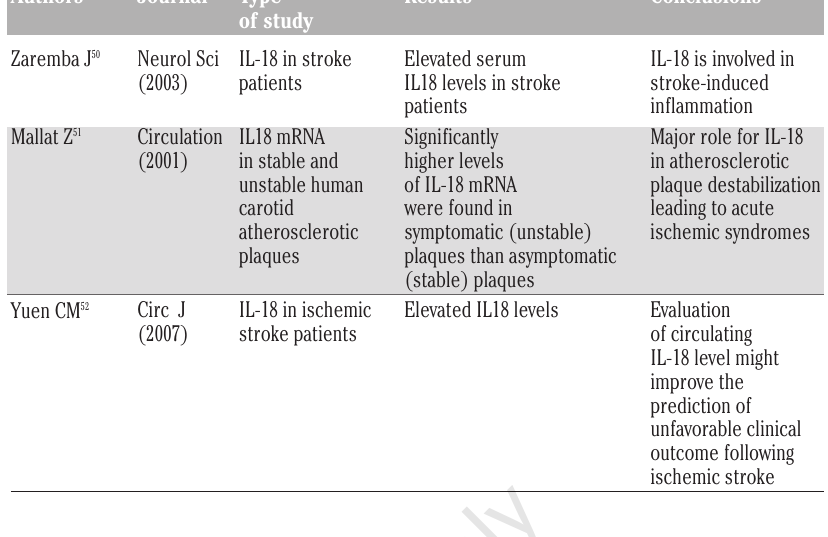
Table 3. S100 b in